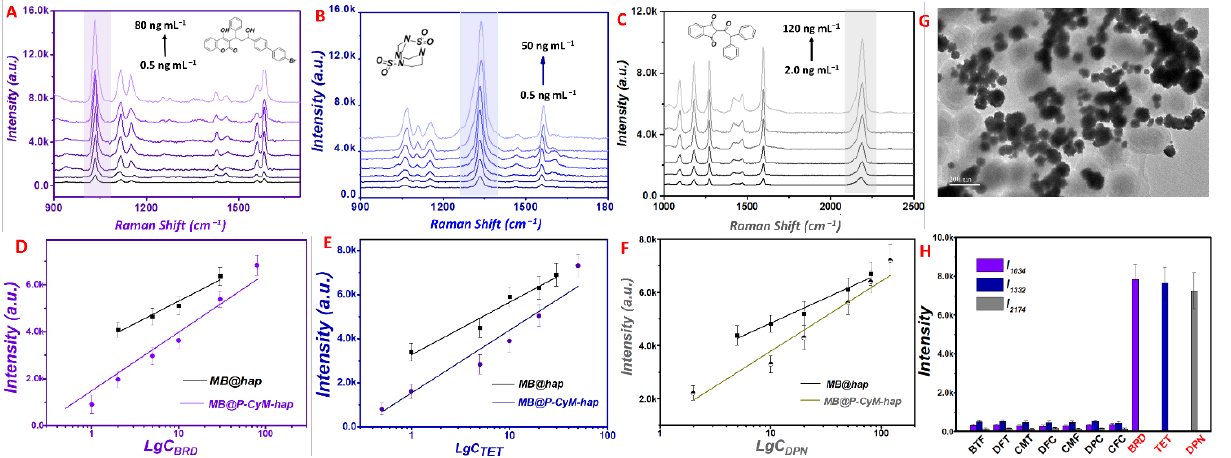
Figure 3. SERS spectra and the corresponding linear calibration curve for the detection of BRD ( A , D ), TET ( B , E ) as well as for DPN ( C , F ) using the multiple competitive MB with or without grafting P-CyM in PBS buffer. Each data point was the mean of triplicate analyses. ( G ) TEM images demonstrated the specific binding among the MB@P-CyM-hap and SERS nanoprobes. ( H ) Selectivity of this method. All of the interferences were at 1.0 μ g mL −1 .